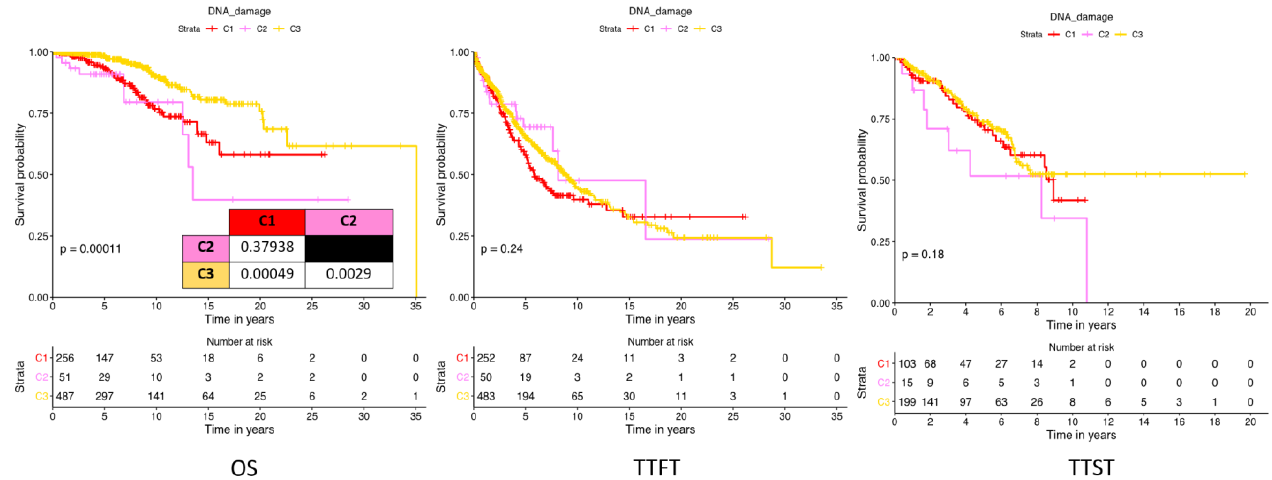
Figure 3. Effect of DDR protein cluster membership on the outcome. Kaplan–Meier plots of the association between the three DDR protein clusters on overall survival ( Left ), time to first treatment ( Center ), and time to second treatment ( Right ) in all CLL patients is shown. For overall survival, comparisons between patients in C1 and C2 were statistically similar (BH p -value 0.38) but were both distinct from C3 (vs. C1, BH p -value < 0.001 and vs. C2, p -value 0.002). For the time to first and second treatments, there were no significant differences.